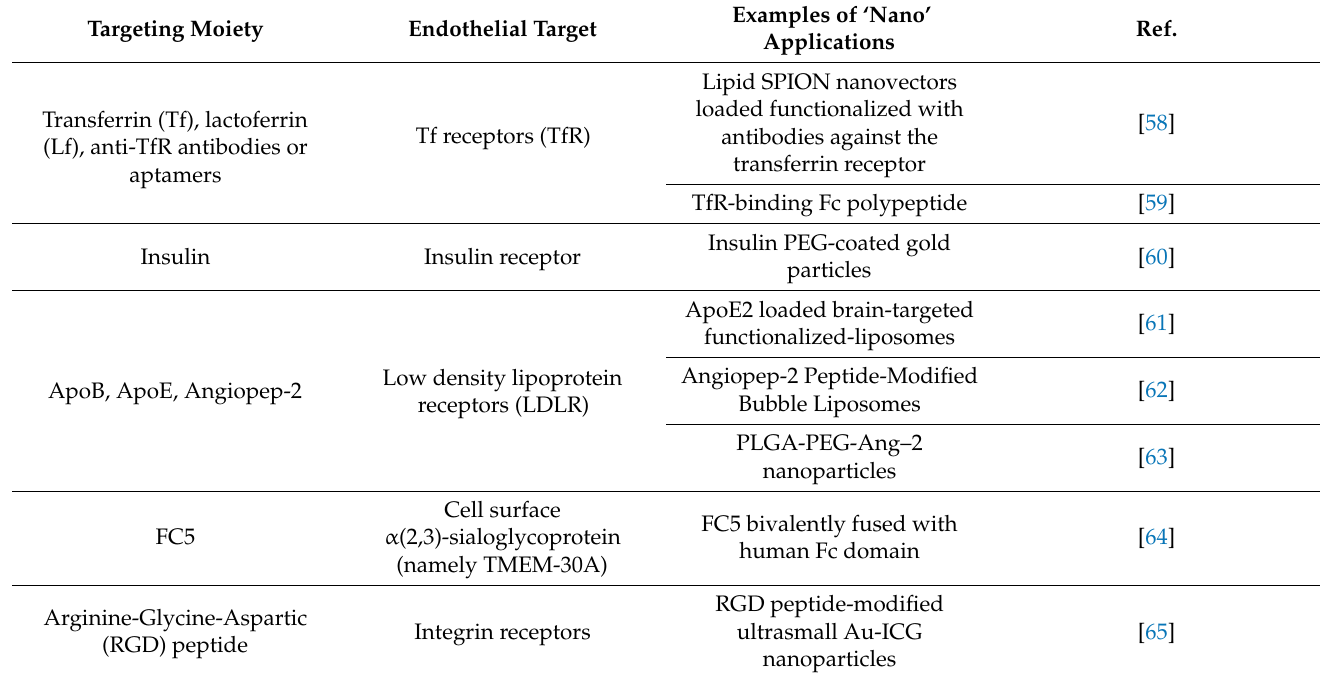
Table 2. Most common targeting moieties allowing agents to bypass the BBB. Examples of ‘Nano’ Targeting Moiety Endothelial Target